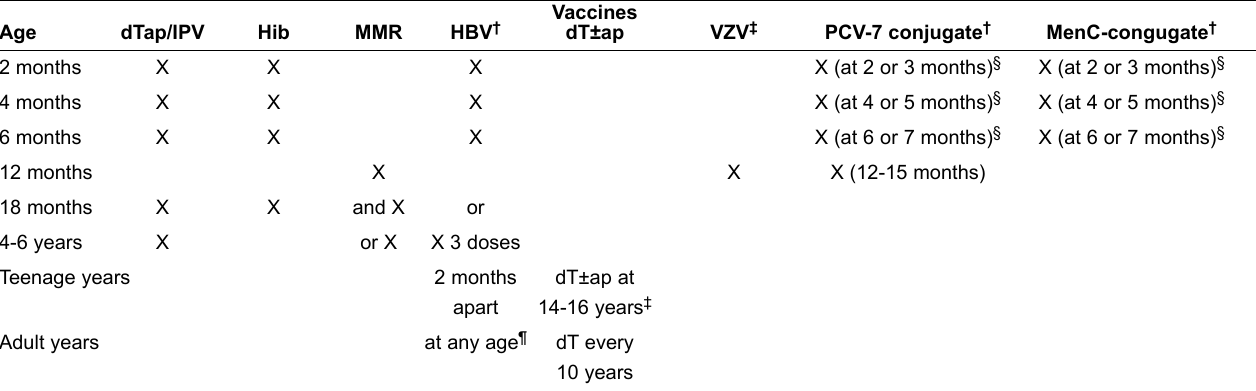
TABLE 1 Routine vaccine schedule for healthy children and adolescents*